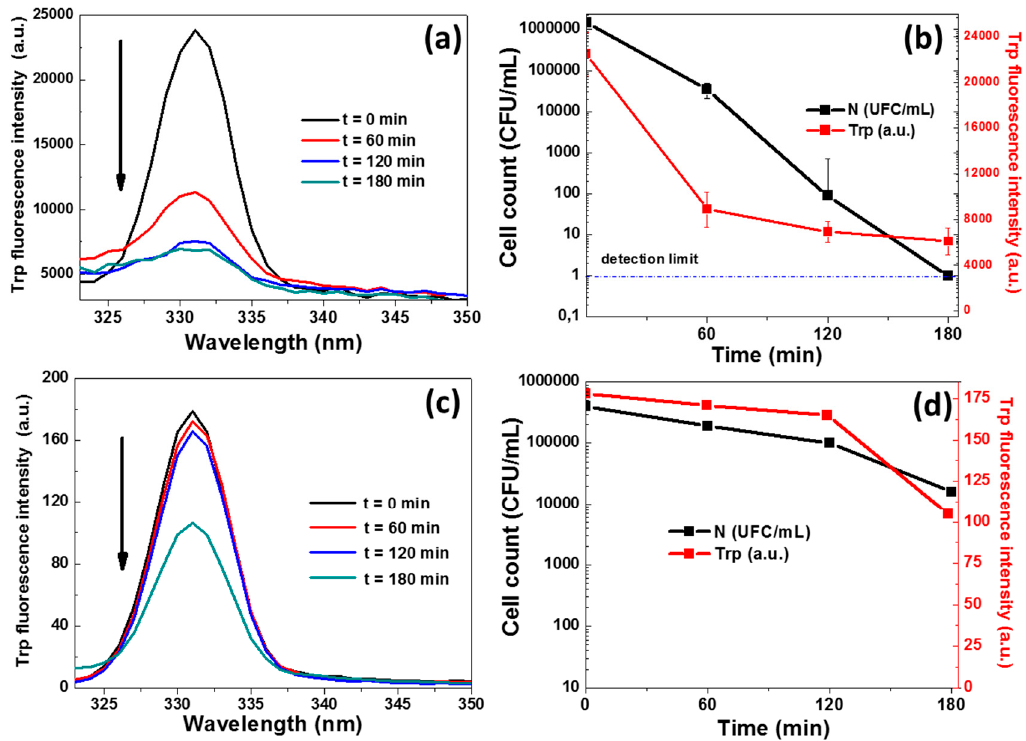
Figure 5. ( a , c ) Trp fluorescence emission spectra and ( b , d ) time evolution of Trp fluorescence intensity and bacterial cultivability (CFU) during photocatalytic experiments with ( a , b ) dispersed and ( c , d ) fixed ZnO NRs.